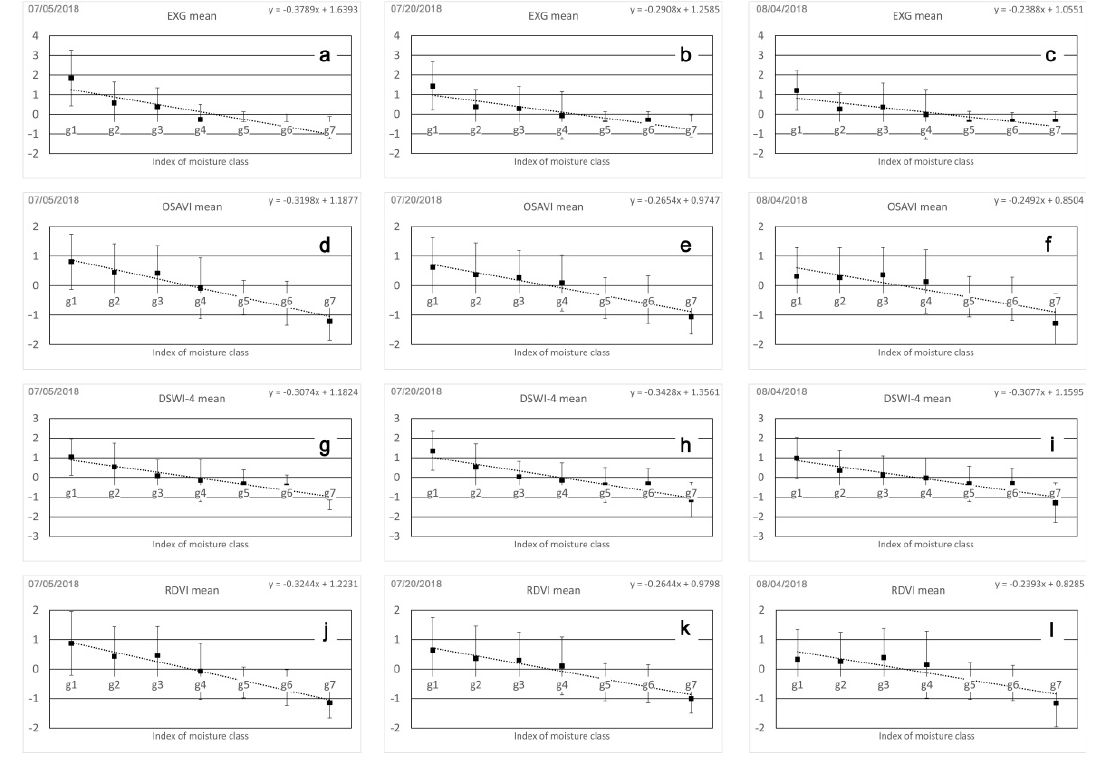
Figure 5 . Average value of top indies in seven FHMIs: ( a ) EXG on 5 July 2018; ( b ) EXG on 20 July 2018; ( c ) EXG on 4 August 2018; ( d ) OSAVI on 5 July 2018; ( e ) OSAVI on 20 July 2018; ( f ) OSAVI on 4 August 2018; ( g ) DSWI-4 on 5 July 2018; ( h ) DSWI-4 on 20 July 2018; ( i ) DSWI-4 on 4 August 2018; ( j ) RDVI on 5 July 2018; ( k ) RDVI on 20 July 2018; ( l ) RDVI on 4 August 2018.